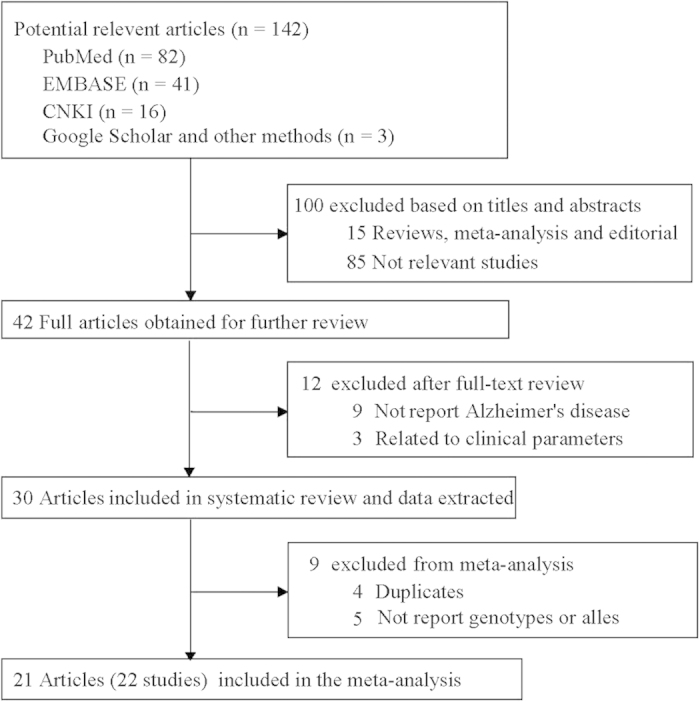
Flow chart of selection studies in our meta-analysis.